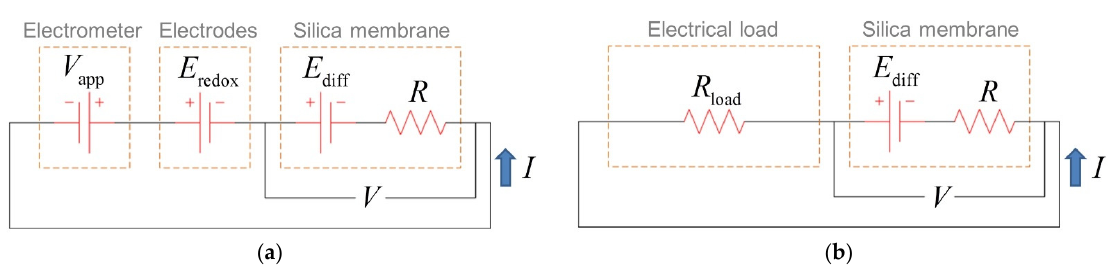
Figure 5. ( a ) Basic circuit elements representing the experimental setup; and ( b ) equivalent circuit for this setup in which the source meter and the electrode are considered the electrical load R load connected to the silica membrane